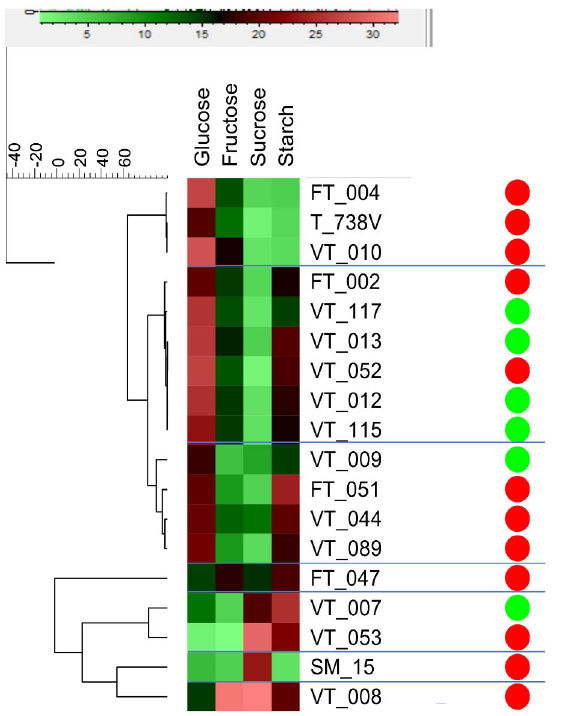
Figure 7. Hierarchical clustering in UPGMA obtained based on sugar and starch content measured on turnip tubers from 18 turnip accessions. Color gradient indicates the percentage of each carbohydrate in the freeze-dried mature tuber samples. Green and red dots on the left side indicate Asian and European subpopulations respectively.